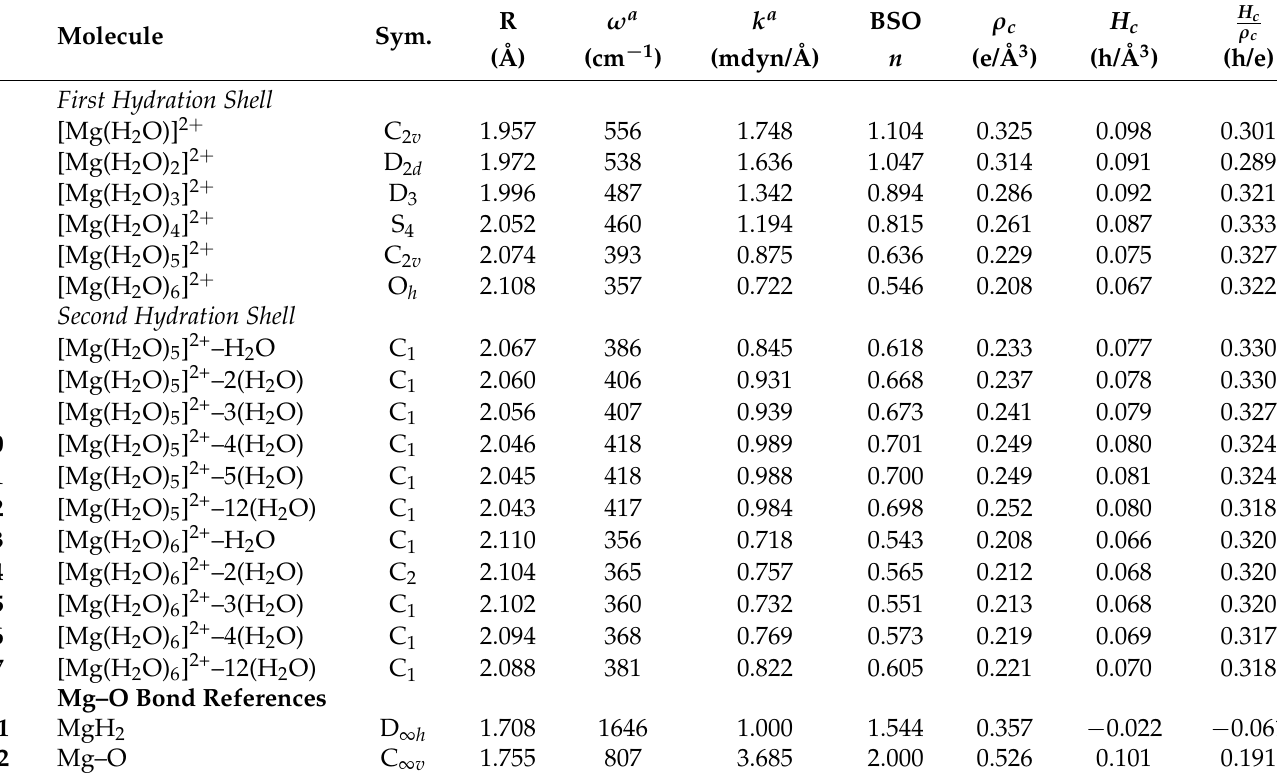
) of Mg–O interactions for clusters 1 – 17 ρ c